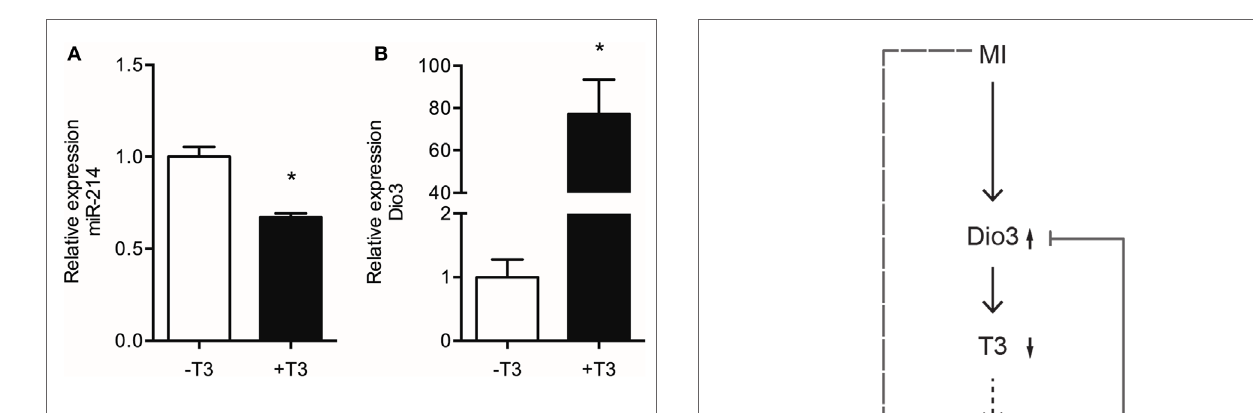
FigUre 7 | effect of T3 treatment on the levels of mir-214 and Dio3 mrna . Total RNA isolated from the LV of hypothyroid ( − T3) and hypothyroid mice treated with T3 for three days ( + T3) was analyzed by qPCR for miR-214 expression using U6 snRNA as correction factor (a) , and for Dio3 mRNA expression using Hprt as correction factor (B) . Values are means ± SEM, n = 6, normalized to the − T3 values, * p <